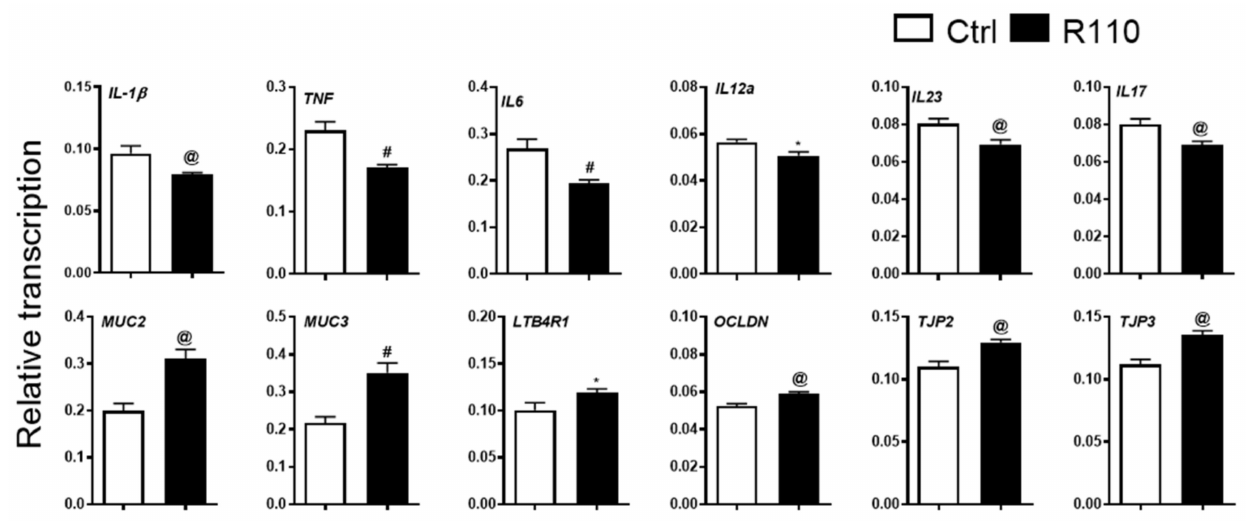
Figure 3. SlpA reduces local inflammation and leaky gut. Total RNA was isolated from the distal colon of mice from Rag1 − / − mice after eight weeks of T cell-mediated colitis initiation. Results represent means ± SEMs from three independent experiments; n = 7–12; * p < 0.05; @ p < 0.01; # p <